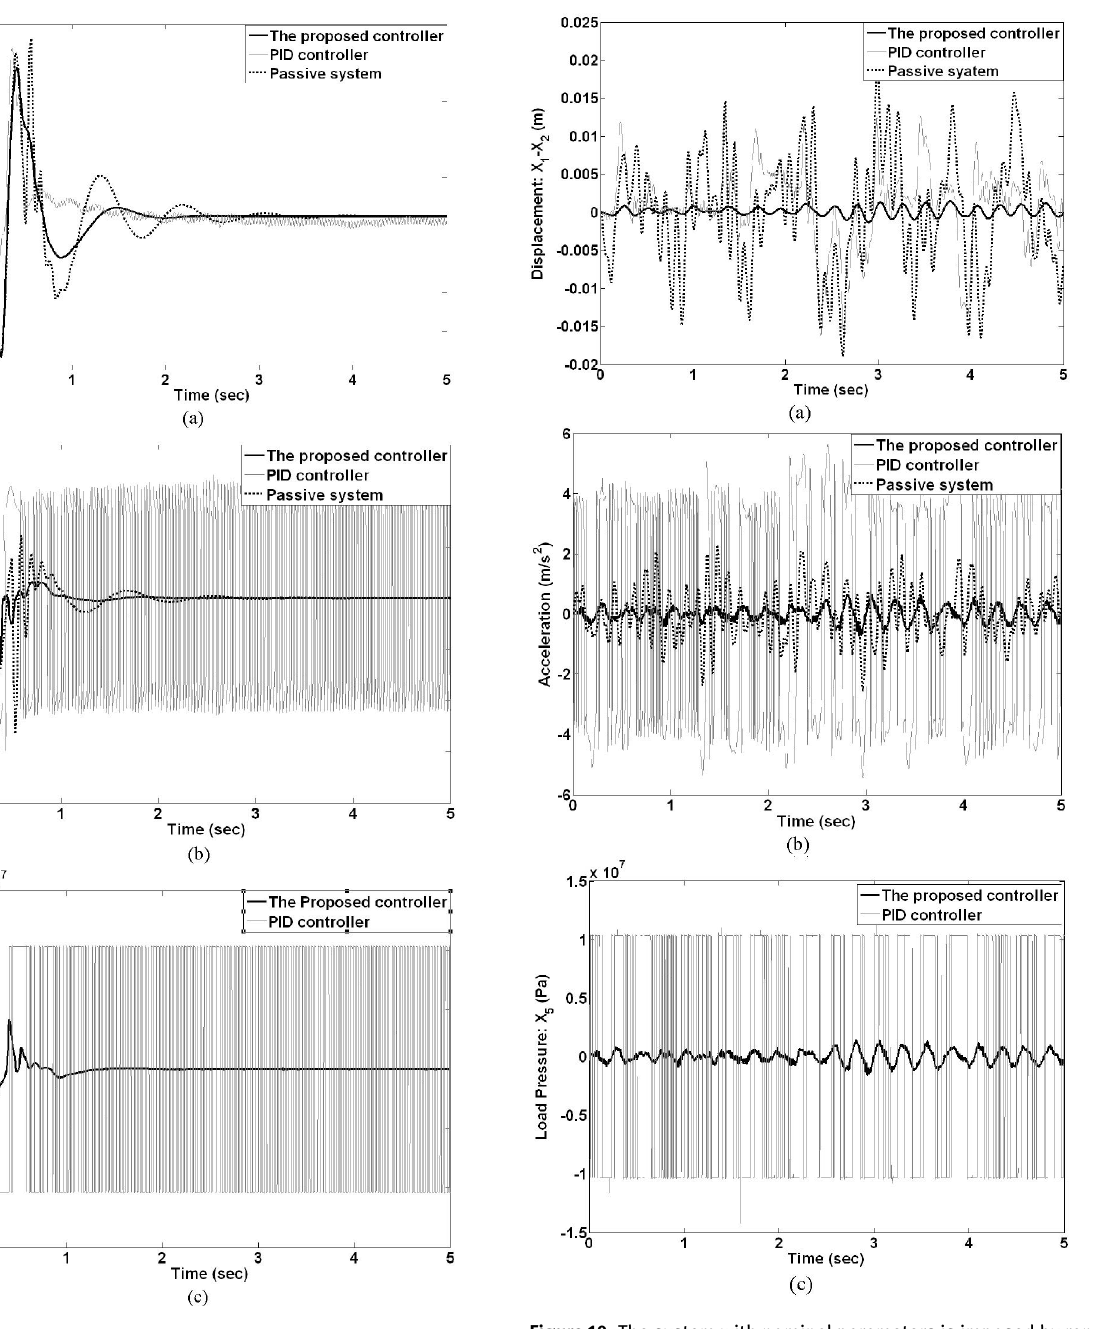
Figure 9. The system with nominal parameters is imposed by bump road profile depicted in Fig. 3. (a) Suspension travel for the pro- posed controller, PID and passive suspension system, (b) Vertical vehicle body acceleration for the proposed controller, PID and pas- sive suspension system, (c) Load pressure for the proposed con- troller and PID controller and PID is applied to the AVSS. Results have been presented in Table 8 and illustrated in Figure 11. As the results show, In spite of changed parameters, the pro-